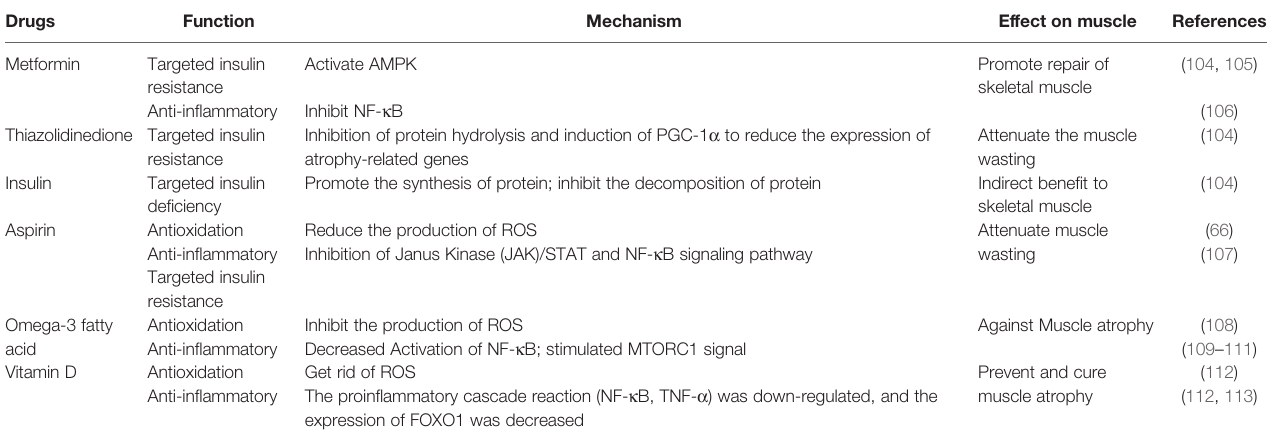
TABLE 1 | Treatments and therapeutic drugs for diabetic muscular